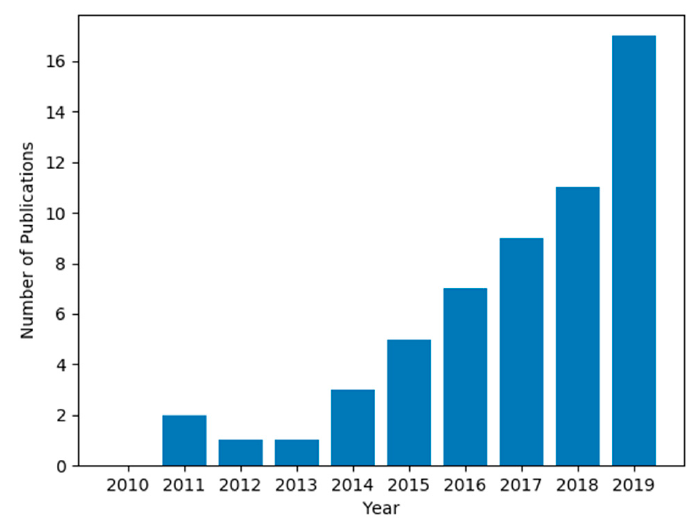
Figure A1. The number of publications examined within the review, segmented by the original